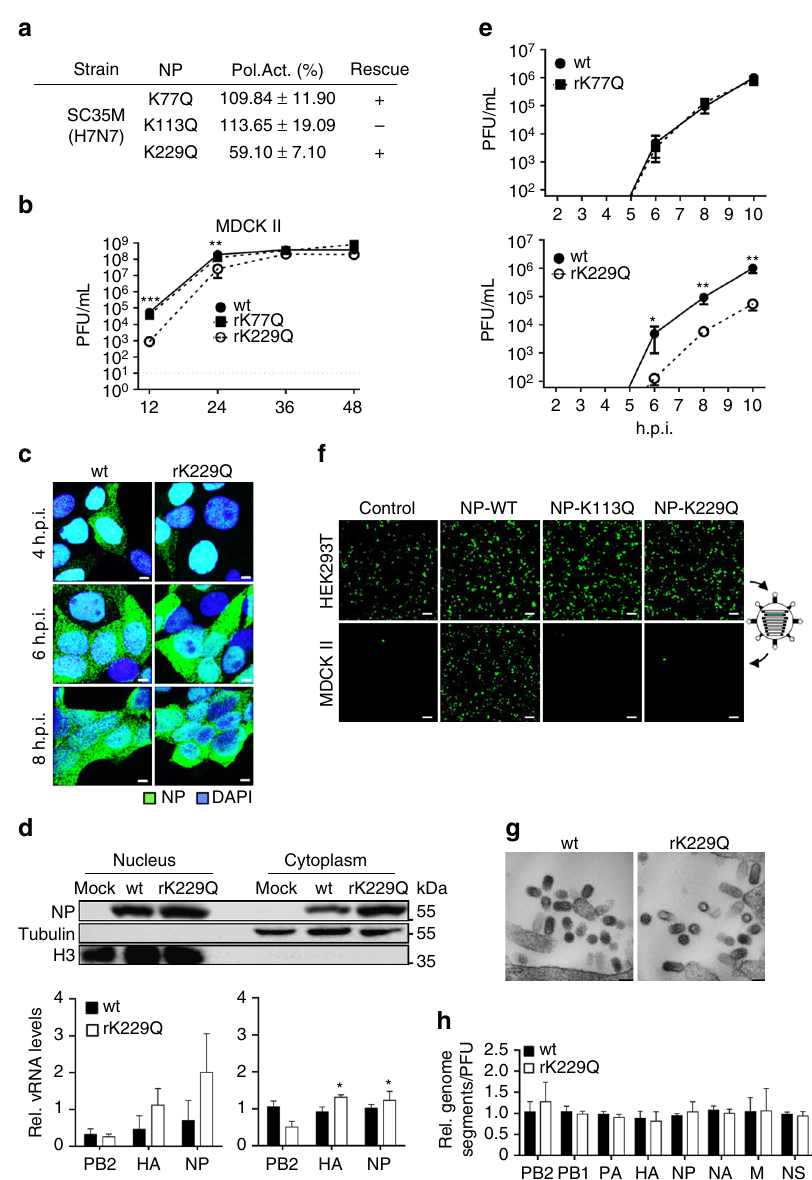
Fig. 4 Impact on viral replication and growth mimicking constant NP acetylation. a Polymerase reconstitution assay in HEK293T cells in the presence of the indicated NP mutants. Polymerase activity is shown as mean and s.d. of at least three independent experiments. Plus indicates successful rescue of recombinant viruses. b MDCK II cells were infected at an MOI of 0.001 and viral growth was monitored at the indicated time points by plaque assay. Dashed lines represent the detection limit. ** p < 0.01; *** p < 0.001. Error bars indicate the mean and s.e.m. of at least three independent experiments. c Subcellular localization of NP in MDCK II cells infected with the indicated viruses at an MOI of 5 after 4, 6 and 8 h.p.i. Scale bars = 4 µ m. d NP protein (upper panels) and vRNA transcript (PB2, HA, NP) levels (lower panels) were determined in nuclear and cytoplasmic fractions 6 h.p.i. of MDCK II cells infected at an MOI of 5 by Western blot analysis and quantitative RT – PCR, respectively. β -Tubulin and histone H3 were used as marker for speci fi c fractionation. Error bars indicate the mean and s.d. of at least three independent experiments. * p < 0.05. e Infection of MDCK II cells (MOI 10) was synchronized on ice and viral titers were subsequently determined via plaque assay. Error bars indicate the mean and standard error of the mean (s.e.m) of at least four independent experiments. Student ’ s t -test was used for two-group comparisons. * p < 0.05; ** p < 0.01. f VLPs were generated in HEK293T cells in the presence of a GFP-encoding reporter segment with the remaining seven genome segments. VLPs released into the cell supernatant were used to infect MDCK II cells, which were subsequently superinfected with SC35M. Scale bar = 100 µ m. g MDCK II cells were infected (MOI 10), fi xed 10 h.p.i. and subjected to electron microscopy. Representative pictures are shown. Scale bar = 100 nm. h Relative amount of genome segments incorporated into viral particles. Equal amounts of infectious viral particles determined by PFU were analyzed by quantitative RT – PCR. Level of wt SC35M genome transcripts were set to 1. Error bars indicate the mean and s.d. of at least three independent experiments. Student ’ s t -test was used for